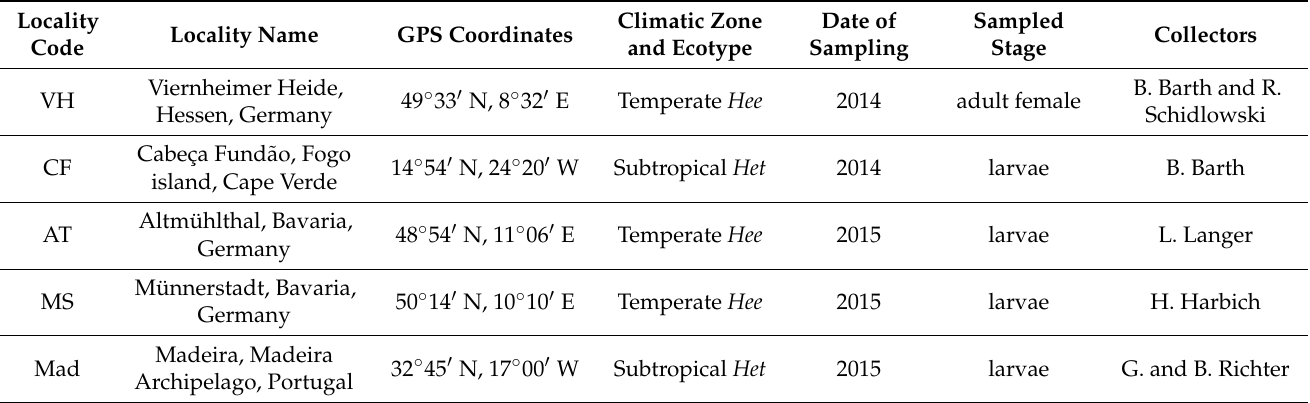
Table 1. Localities of sampled wild H. euphorbiae F0 individuals used to breed progeny for the experiments. Hee –‘euphorbiae’ ecotype, Het –‘tithymali’. See also the map in Appendix